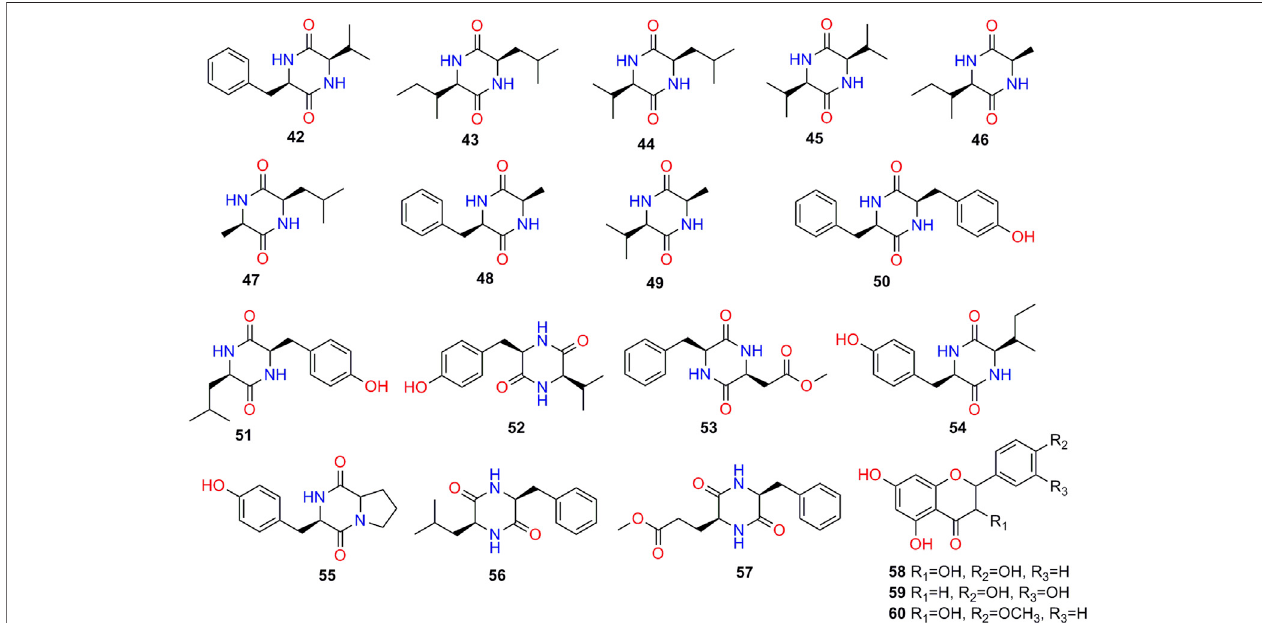
FIGURE 5 | Structures of cyclic dipeptides and fl avonoids isolated from K. galanga .